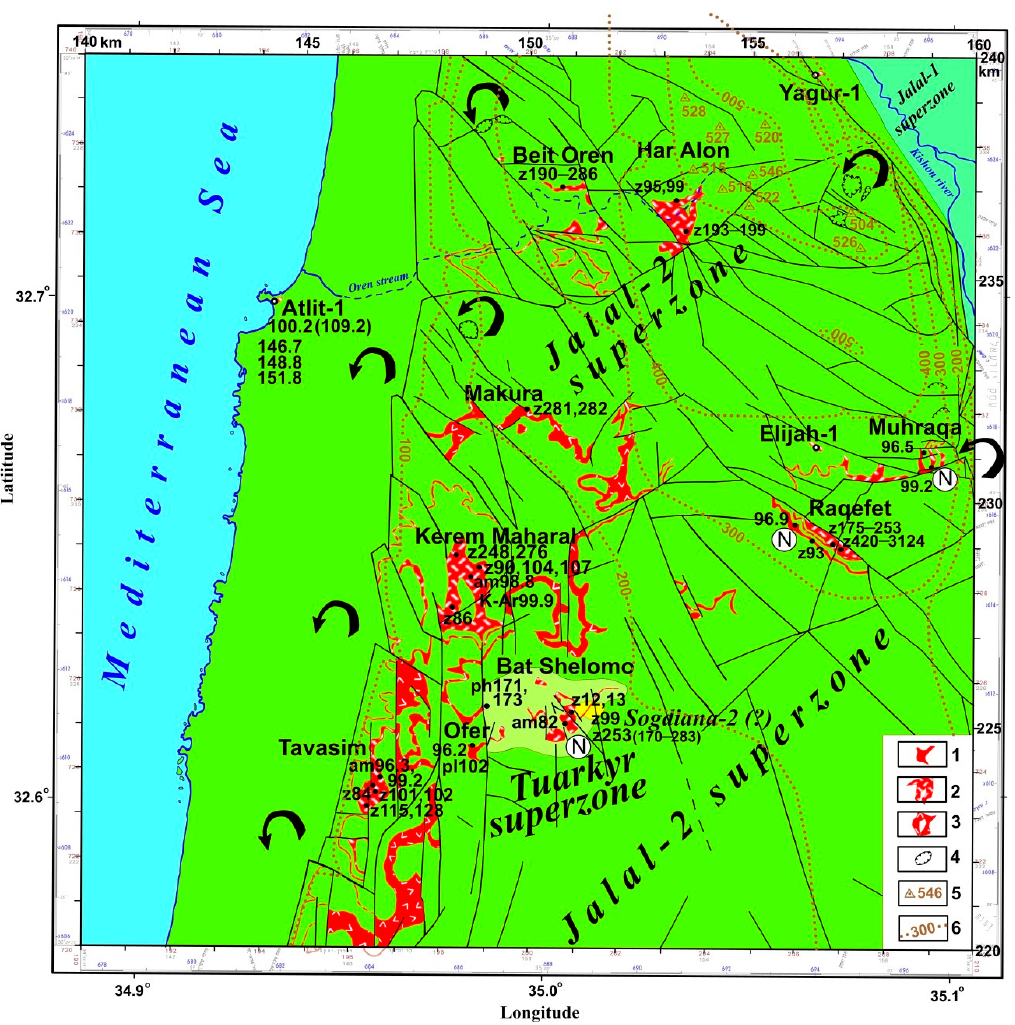
Figure 3. Geodynamic-paleomagnetic map of Atlit area (AT), the middle part of the Carmel area (see its location in Figure 1). This map was developed based on a geological map [57]. (1) basalt lava flows, (2) basalt tuffs, (3) tuffs and flows of basalt volcanic units, (4) landslide scars, (5) highest hypsometric marks, and (6) hypsometric lines.